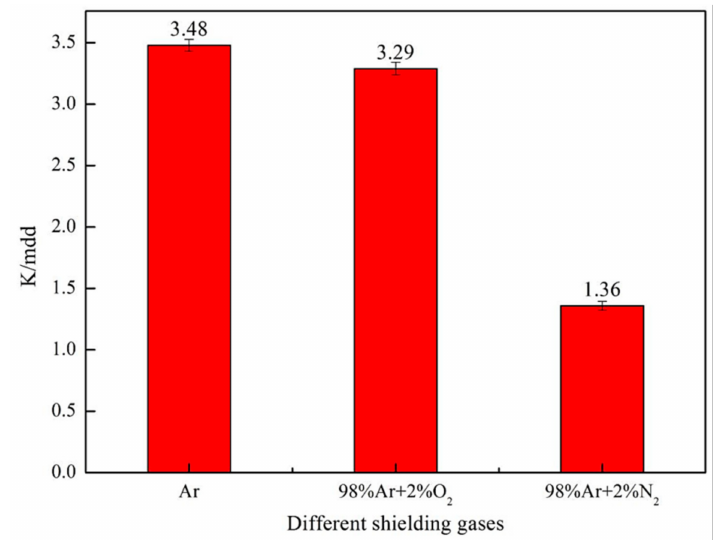
Figure 7. Pitting corrosion rate of welded joint under different shielding